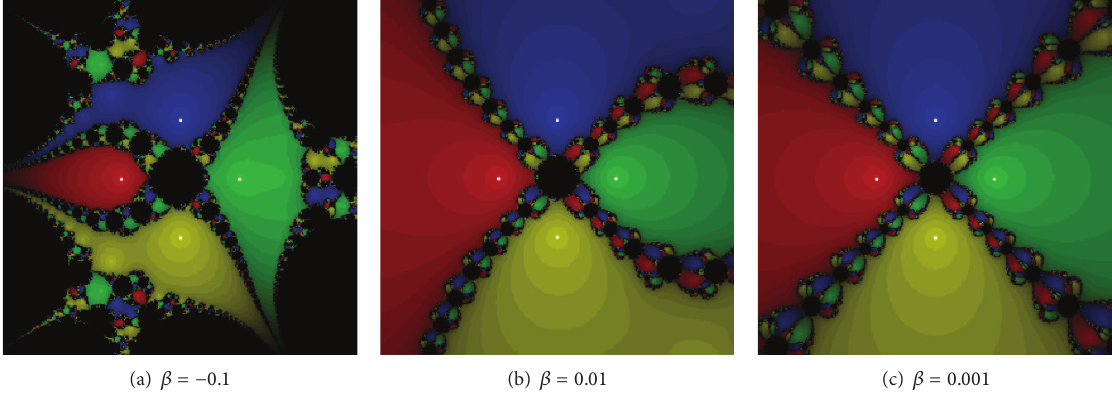
Figure 2: Scheme (3) for the test problem